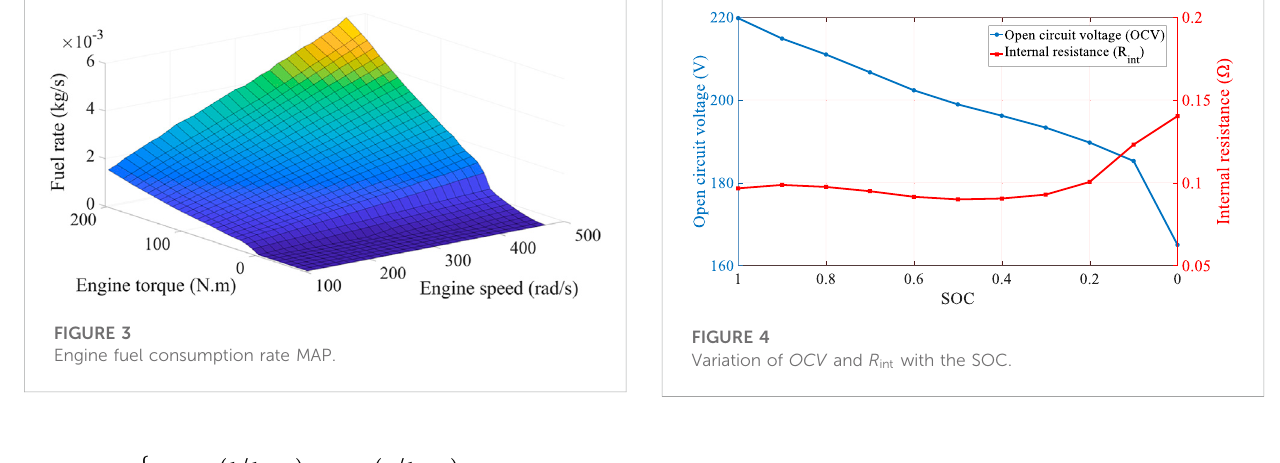
FIGURE 3 Engine fuel consumption rate MAP.